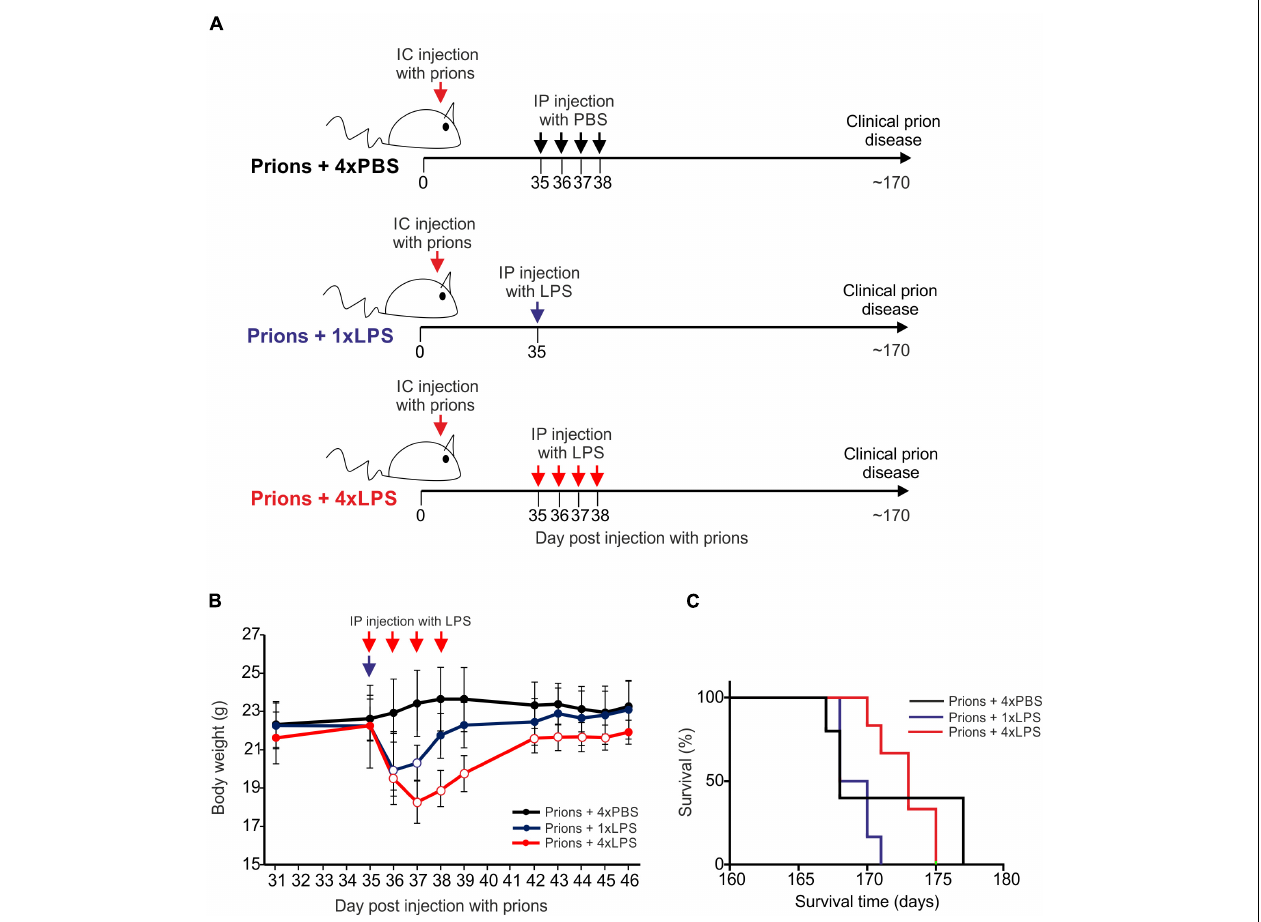
FIGURE 6 | Effect of systemic LPS treatment on CNS prion disease. (A) Cartoon describing the experimental design. Mice were first injected with ME7 scrapie prions directly into the brain by IC injection. Thirty-five days later, the mice were given either a single IP LPS injection (prions + 1xLPS) or four consecutive daily IP LPS injections (prions + 4xLPS) to induce innate immune training or tolerance, respectively. A parallel group of mice were given four consecutive daily IP PBS injections (prions + 4xLPS) as a control. (B) A single IP LPS injection (prions + 1xLPS) or four consecutive daily IP LPS injections (prions + 4xLPS) caused a transient reduction in body weight compared to prions + 4xPBS-treated controls. Open circles, P < 0.05 compared to prions + 4xPBS-treated controls. Closed circles, not significantly different compared to prions + 4xPBS-treated controls. (C) Survival curve for prion infected mice in each treatment group. N = 5–6 mice/group. Not significantly different, Log-rank (Mantel-Cox)